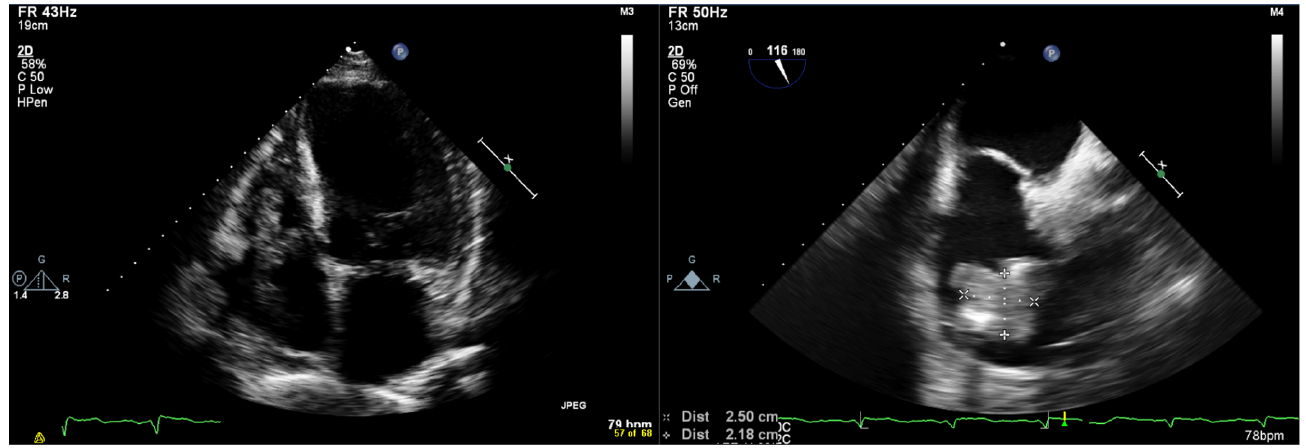
Figure 1. Ventricular pacing wire was inside the right ventricle with a large echogenic mass (2.2 × 2.5 cm) adherent to it. ( Left ) Transthoracic echocardiography study. ( Right ) Transesophageal echocardiography study.